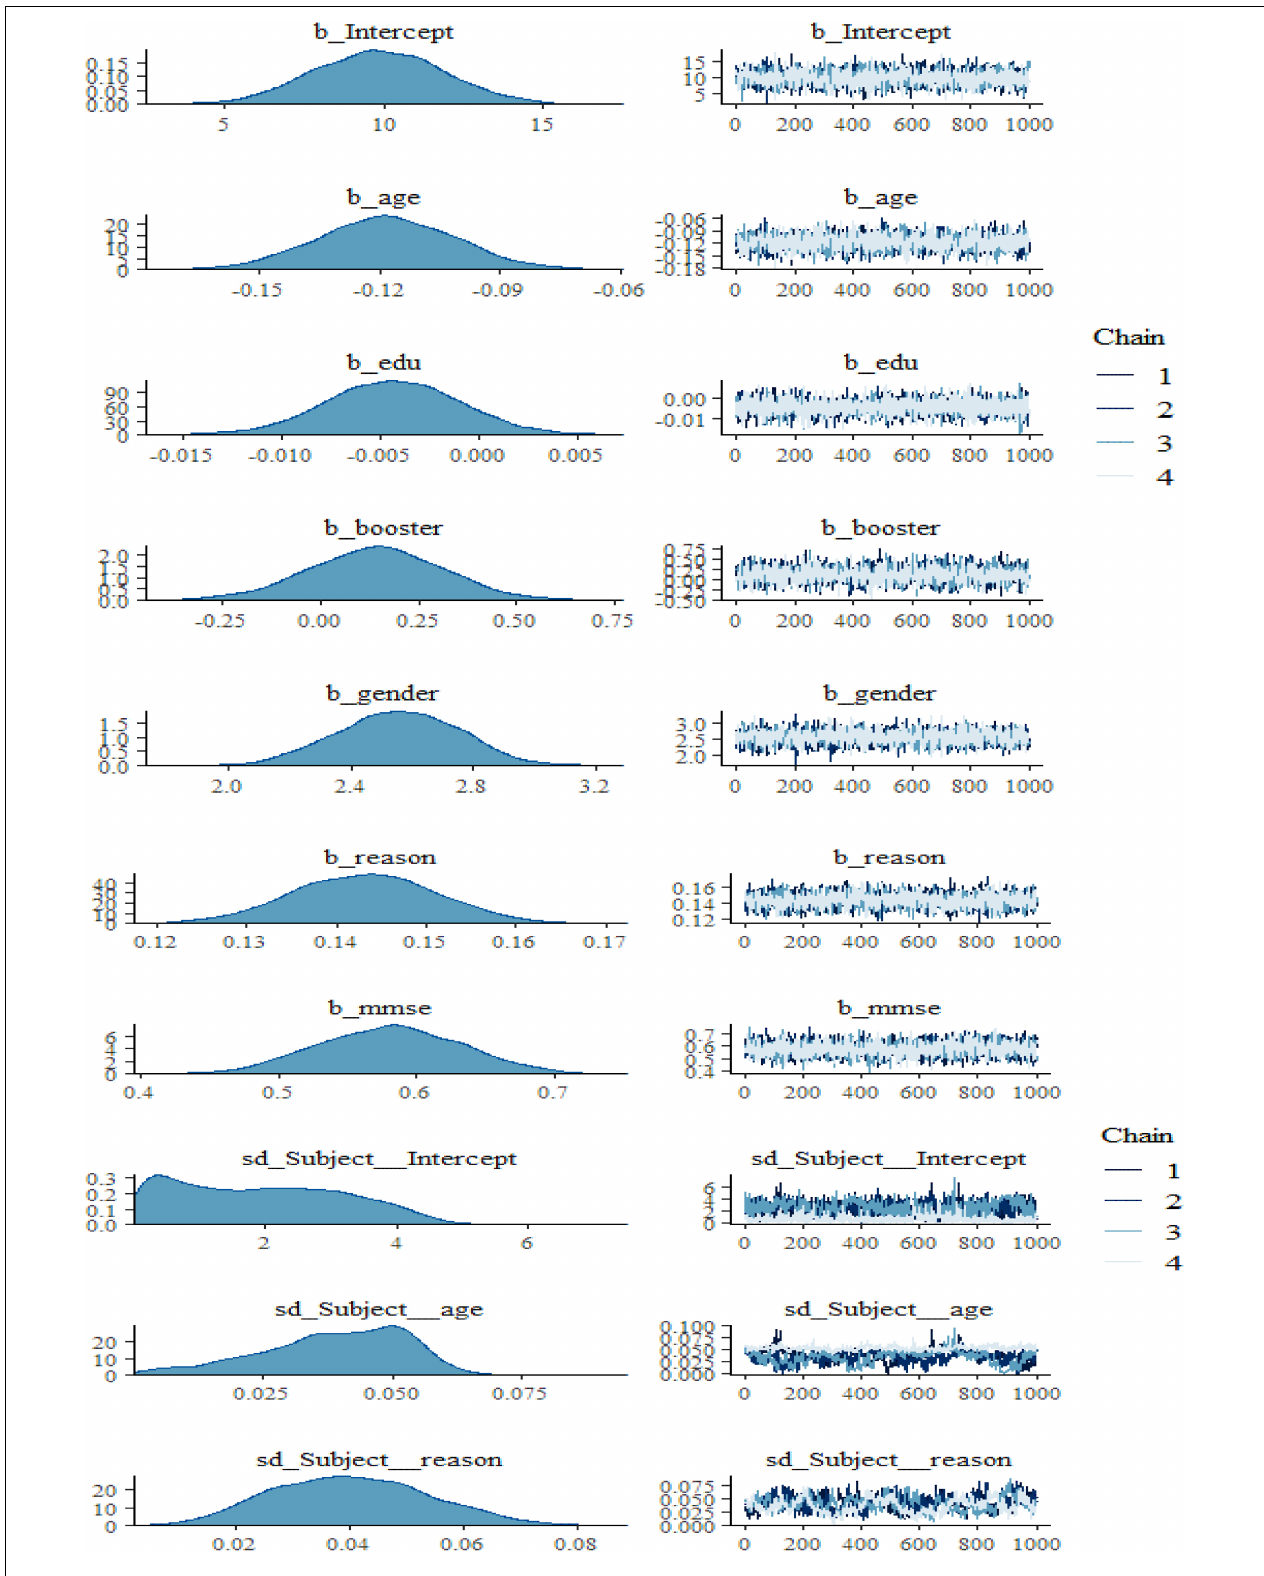
FIGURE 2 | Bayesian hierarchical varying slope convergence